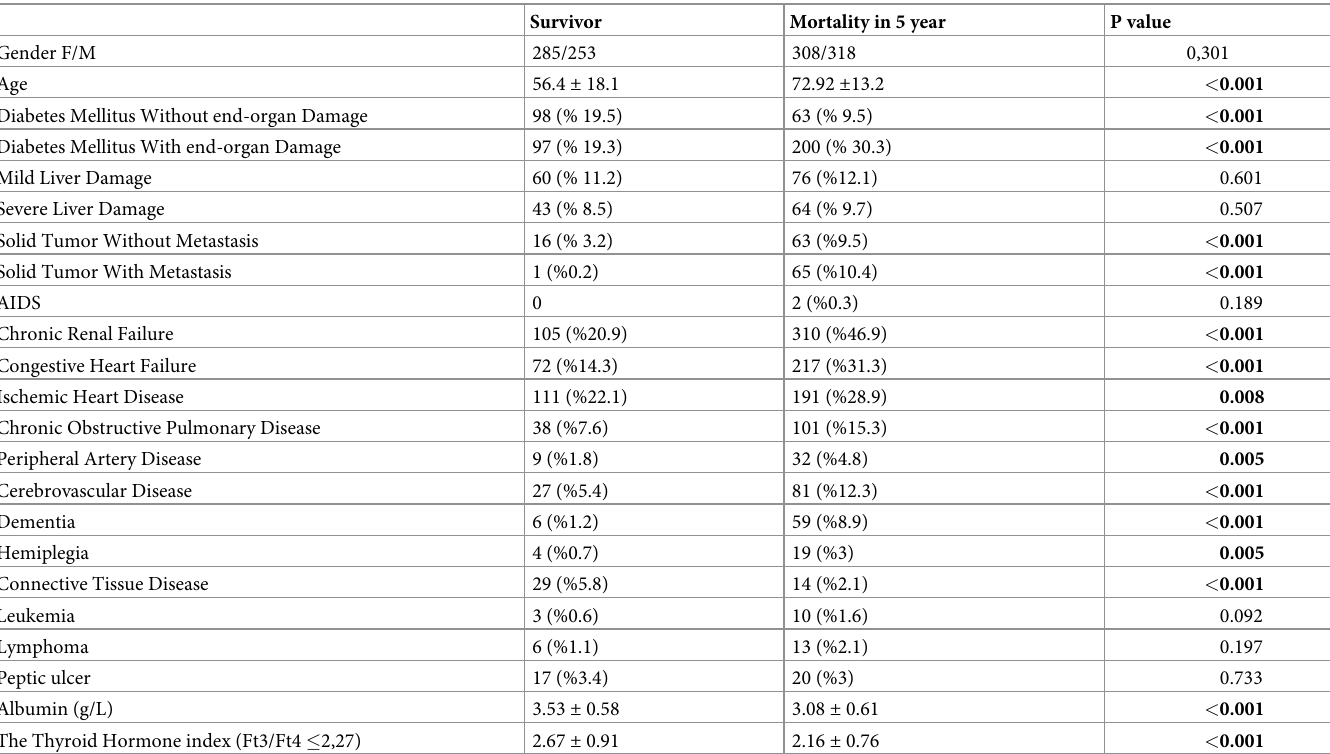
Table 2. Baseline characteristics of patients in 5 year